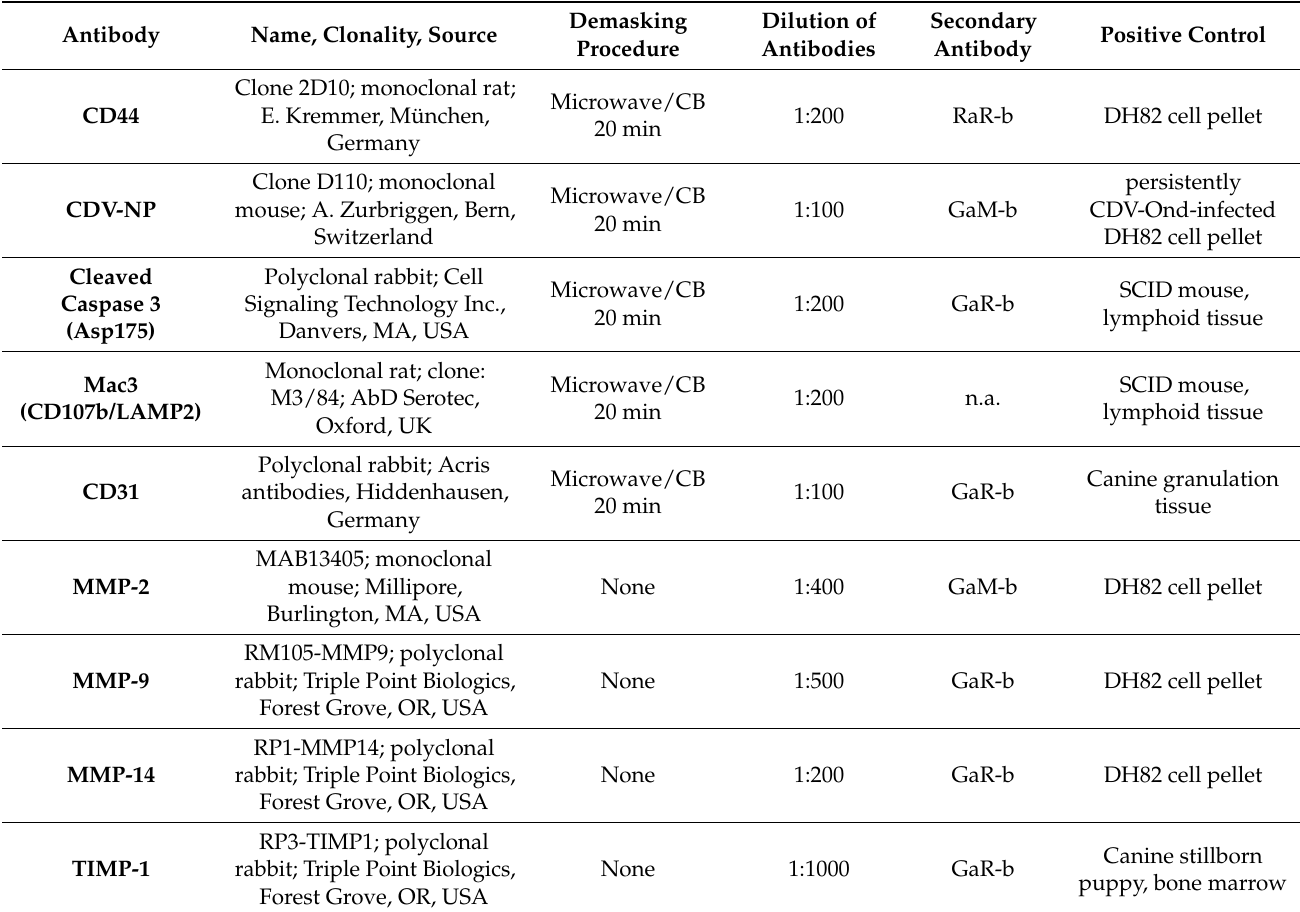
CDV-N = canine distemper virus nucleoprotein; GaM-b = goat-anti-mouse antibody biotinylated; GaR-b = goat-anti-rat antibody biotiny- lated; n.a. = not applicable; RaR-b = rabbit-anti-rat antibody biotinylated; MMP = matrix metalloproteinase; TIMP = tissue inhibitor of matrix metalloproteinase; CB = citrate